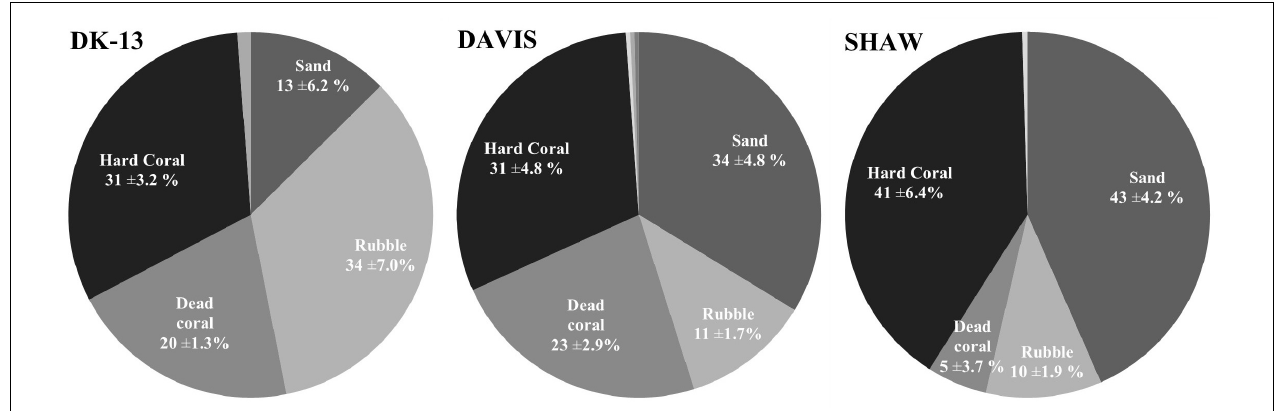
FIGURE 2 | Mean benthic cover ( ± SE) Soft coral made up approximately 1% of benthic cover at all sites and coralline algae was only observed at DK-13 with 1% cover.